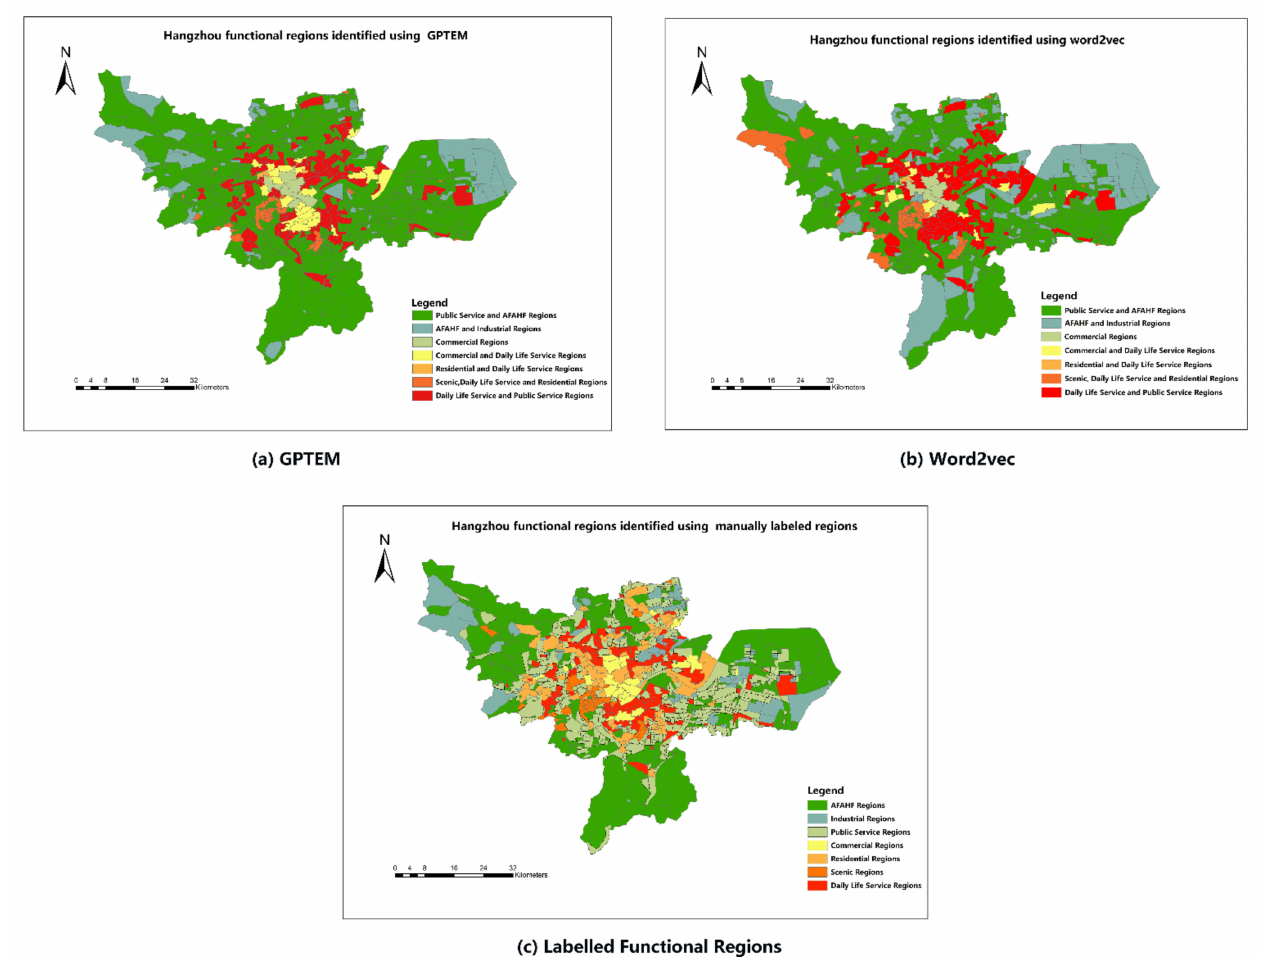
Figure 6. Functional regions identified using different GPTEM ( a ), word2vec ( b ), and ( c ) manually labelled regions. Note: the legend used is different in each